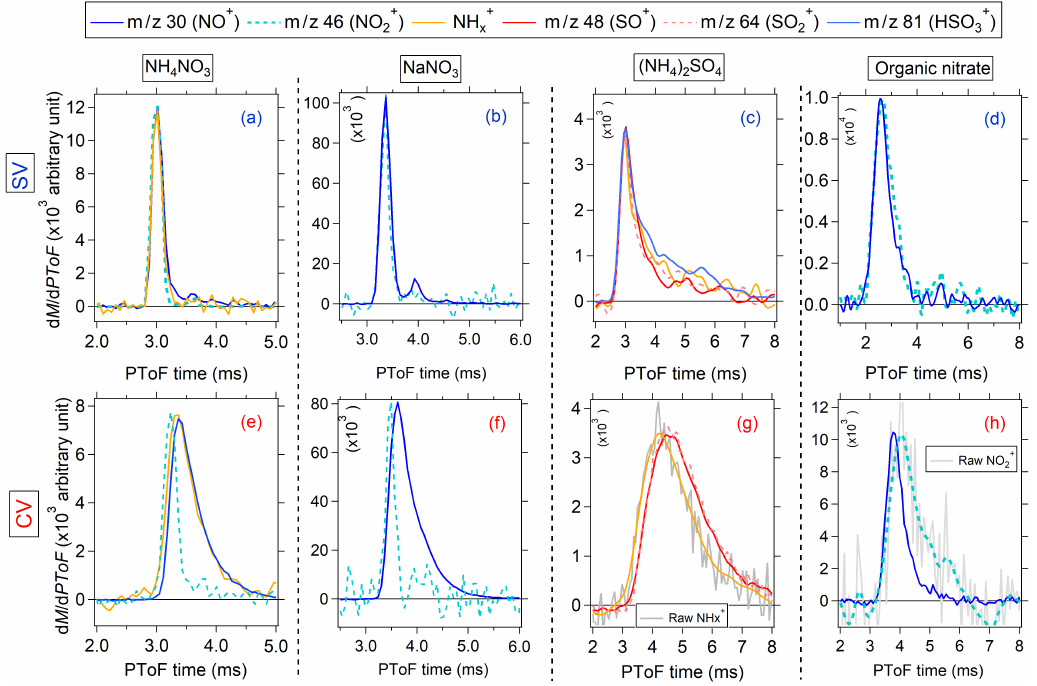
Figure 12. Size-resolved detection (using the PToF acquisition mode) for major ions from 300nm NH 4 NO 3 , 300nm NaNO 3 , 250nm (NH 4 ) 2 SO 4 and chamber-produced organic nitrate in the SV and CV at T v ∼ 500–650 ◦ C. The PToF distributions of NH + x in (g) and of NO + in (h) were 2